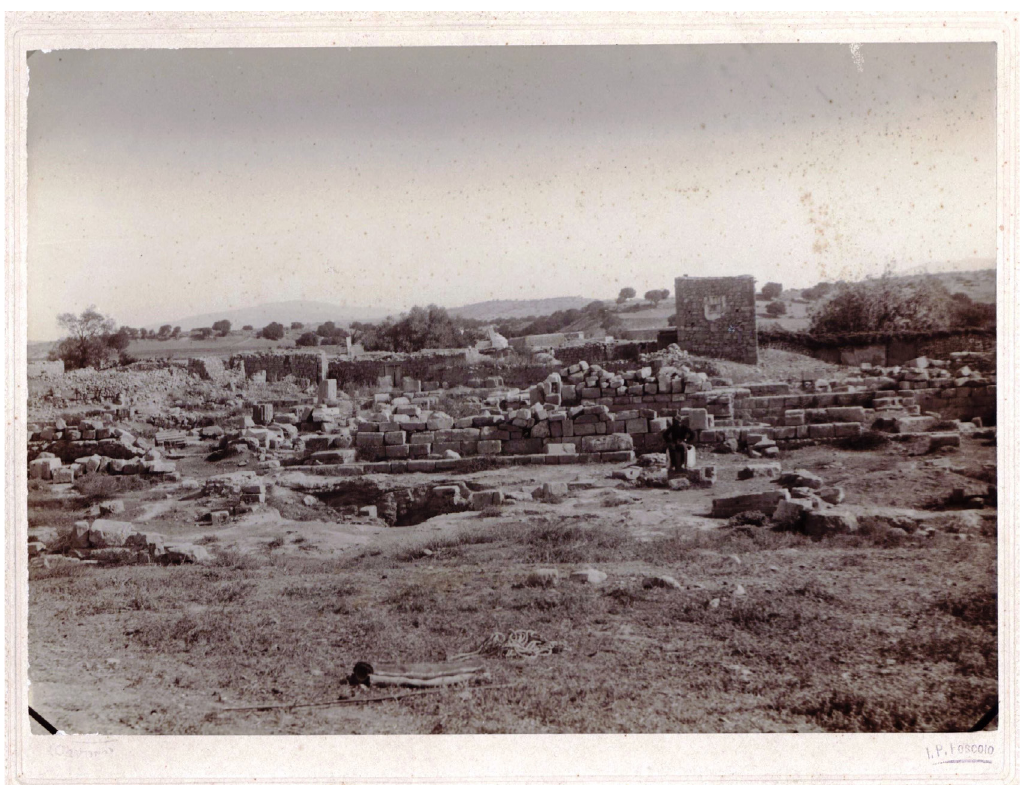
Figure 3. Early photograph (1900) of the ruins of the sanctuary by I. Foscolo. Archive of the Historical and Ethnological Society of Greece. Reproduced by